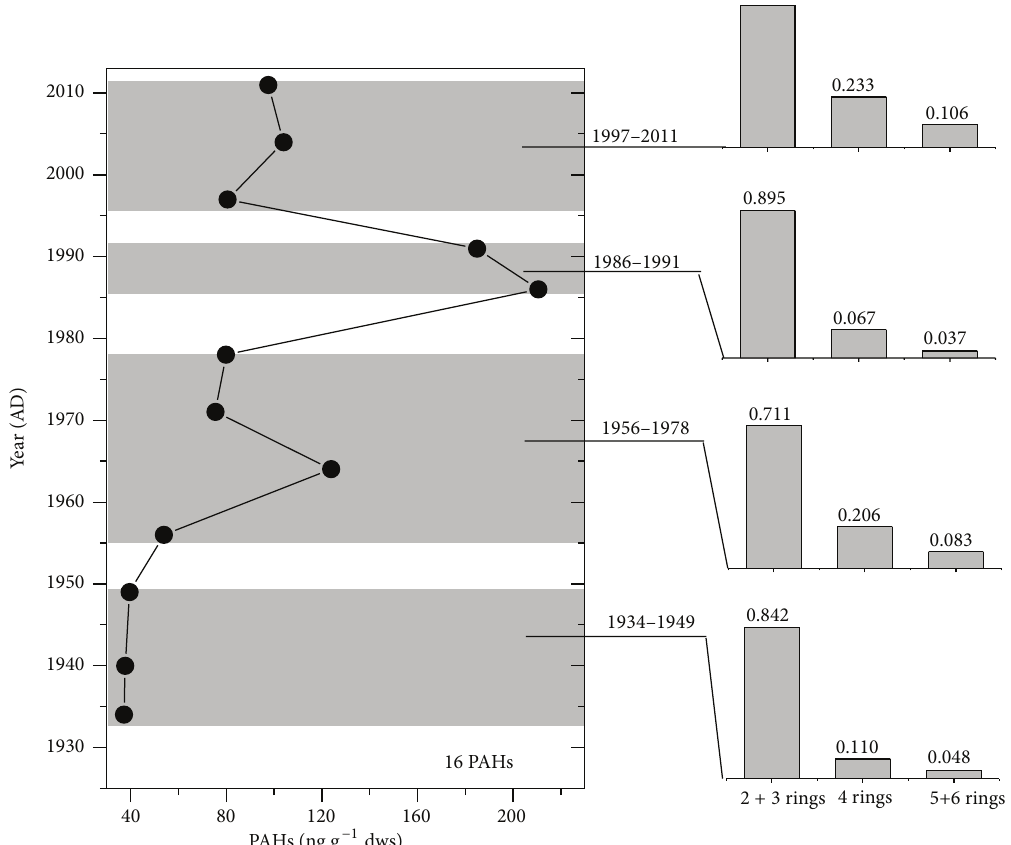
Figure 5: Historical distributions in abundance of total 16 PAHs (ng g −1 dws) and percentage of 2 + 3, 4, and 5 + 6 ring PAHs in sediment core from Southern Bohai Sea.